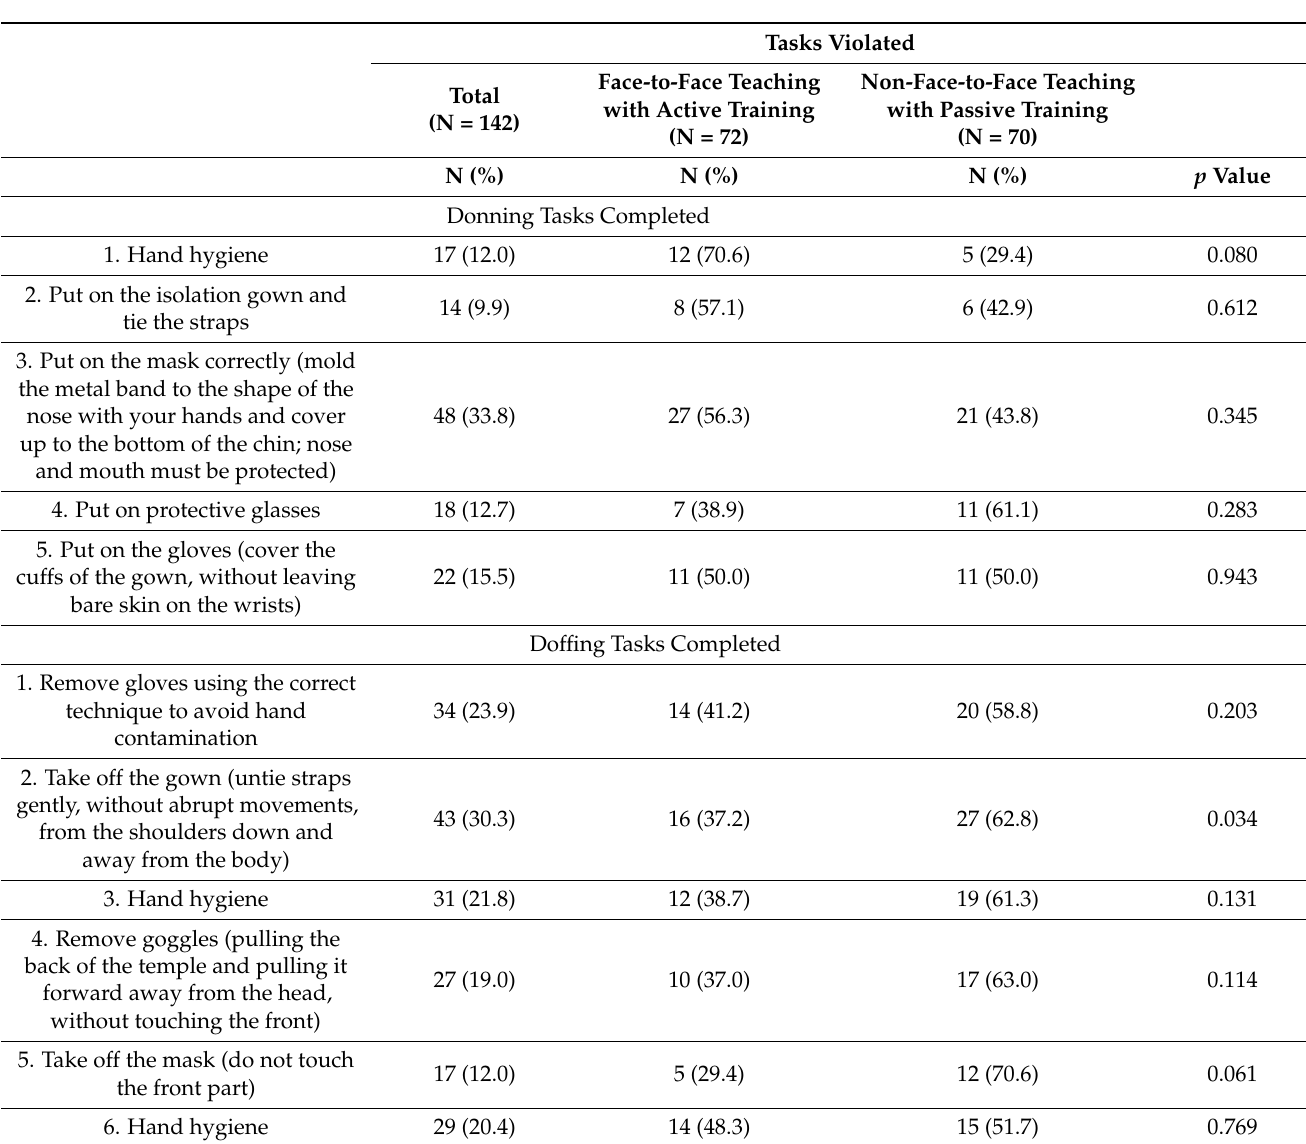
Table 4. Number of donning and doffing tasks violated in the total sample and according to the